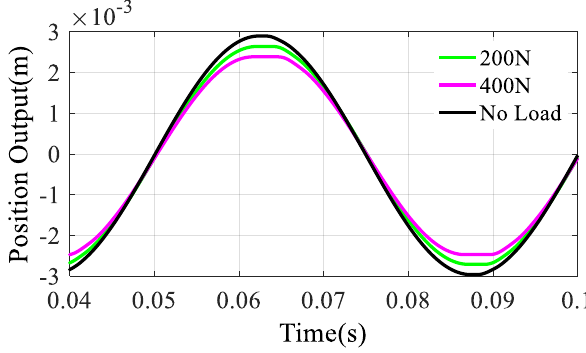
ff erent rectangular